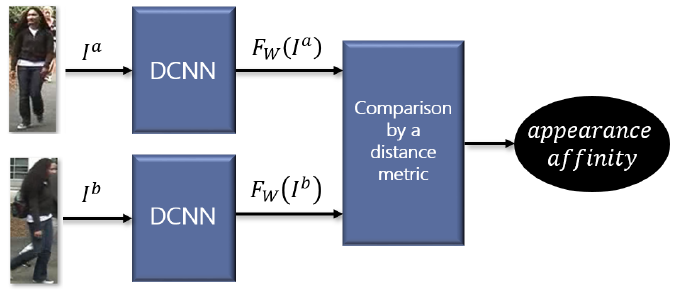
Figure 1. Structure of the neural Appearance Affinity